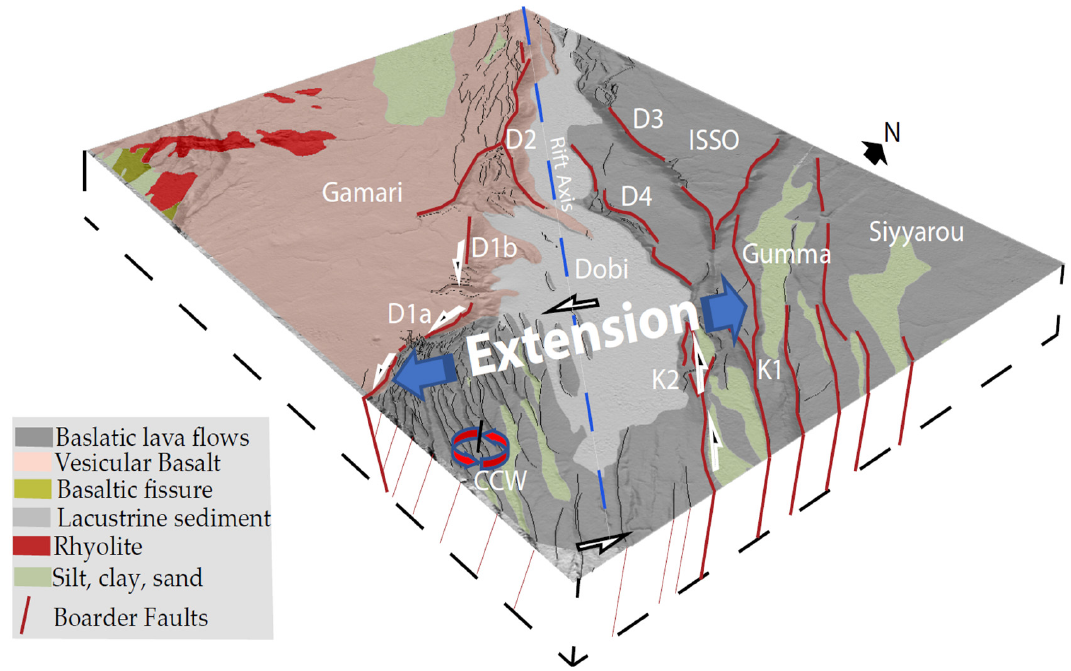
Figure 10. Surface displacement model for the Dobi graben, presumably interpreted as deformation resembling bookshelf faulting, the vertical counterclockwise rotation resulting from differential strain transfer between right-stepping Dobi and Hanle grabens to Dobi fault D1. Halo black arrows exerted a shear couple at the NW-trending normal fault, which exhibited locally sinistral strike-slip shear.